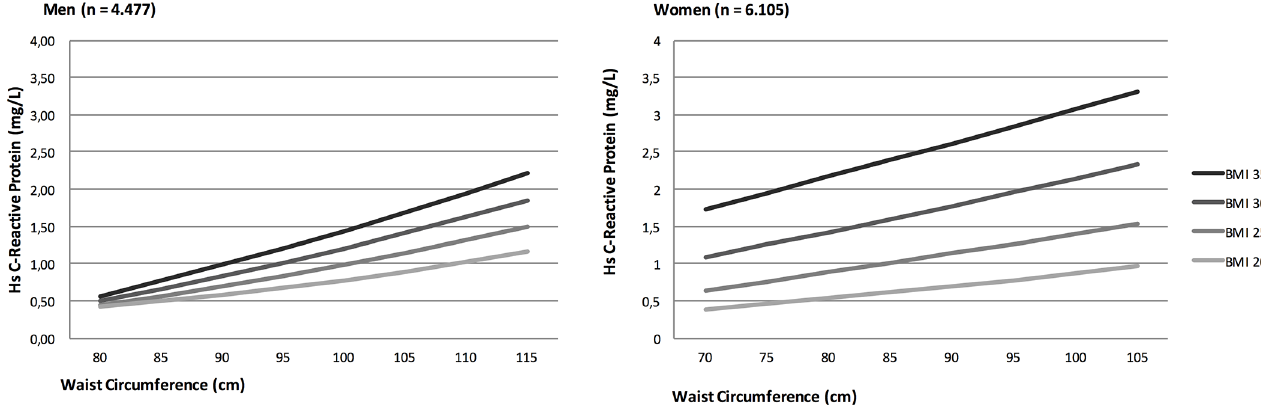
Fig 3. High-sensitivity C-reactive protein by waist circumference and BMI in men and women. Valuesare estimated, from the regression model, for a 40 years old woman or man with a BMI (kg/m 2 ) of respectively20, 25, 30 or 35.